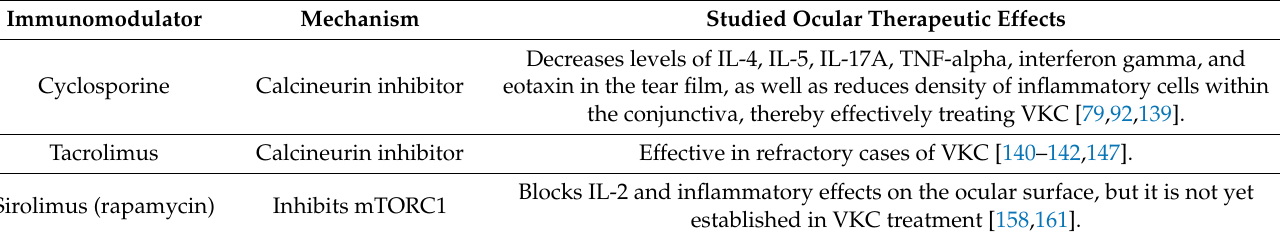
Table 1. Summary of ocular therapeutic effects of immunomodulators.